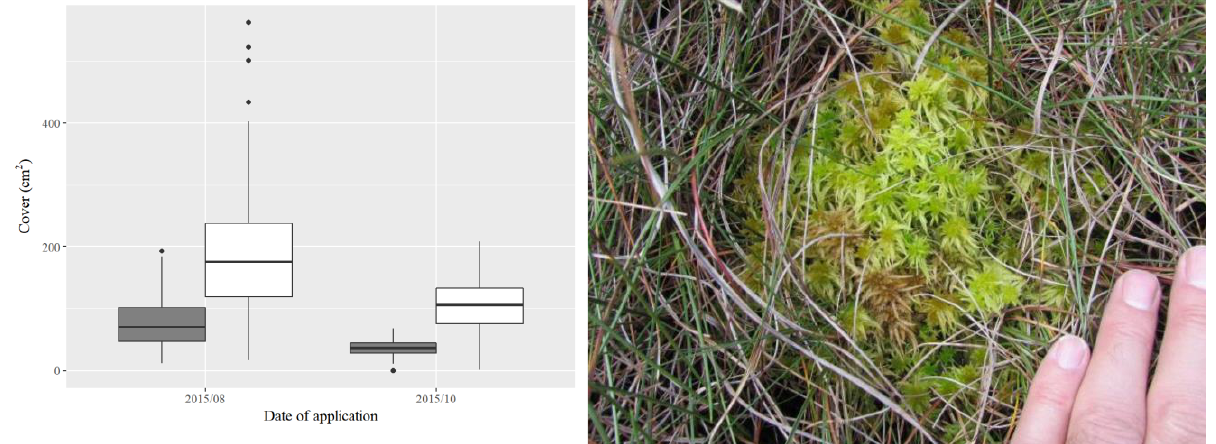
Figure 5. Cover (cm 2 ) of Sphagnum plugs planted into E. angustifolium -dominated blanket bog vegetation in August and October 2015, and later monitored in June (grey) and November (white) 2016 (Trial C). The original cover was 10.2 cm 2 .